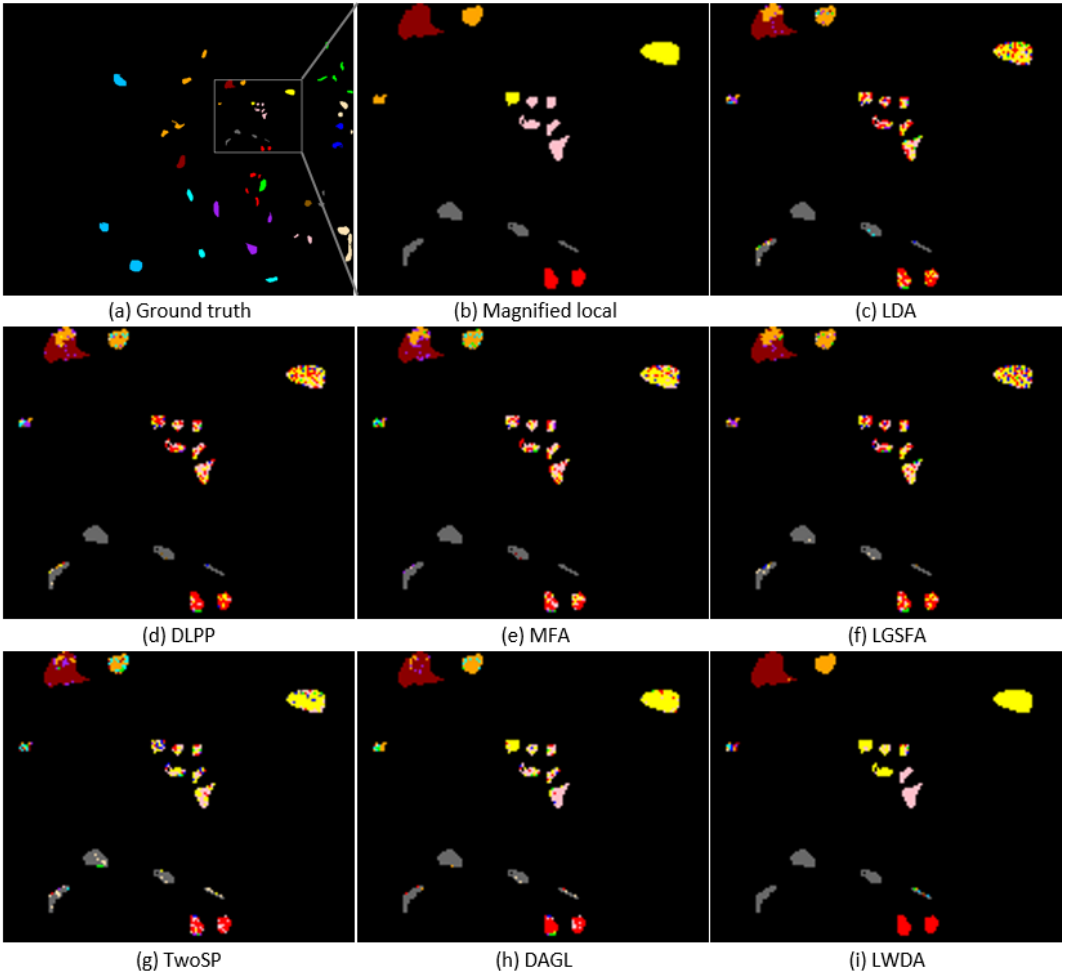
Figure 5. Local magnification (with a magnification factor of 4) of the output classification maps shown in Figure 4. ( a ) Selected local region; ( b ) magnified local region; ( c ) LDA; ( d ) DLPP; ( e ) MFA; ( f ) LGSFA; ( g ) TwoSP; ( h ) DAGL; ( i ) proposed